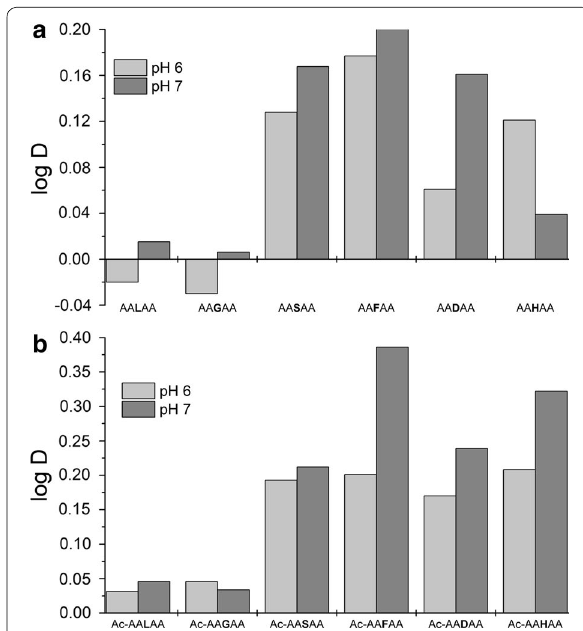
Fig. 3 Distribution ratios of a pentapeptides and b acetylated penta- peptides at pH 6.0 and 7.0 (in IL-ATPS, A alanine, L leucine, G glycine; S serine; F phenylalanine; D aspartic acid; H histidine, Ac